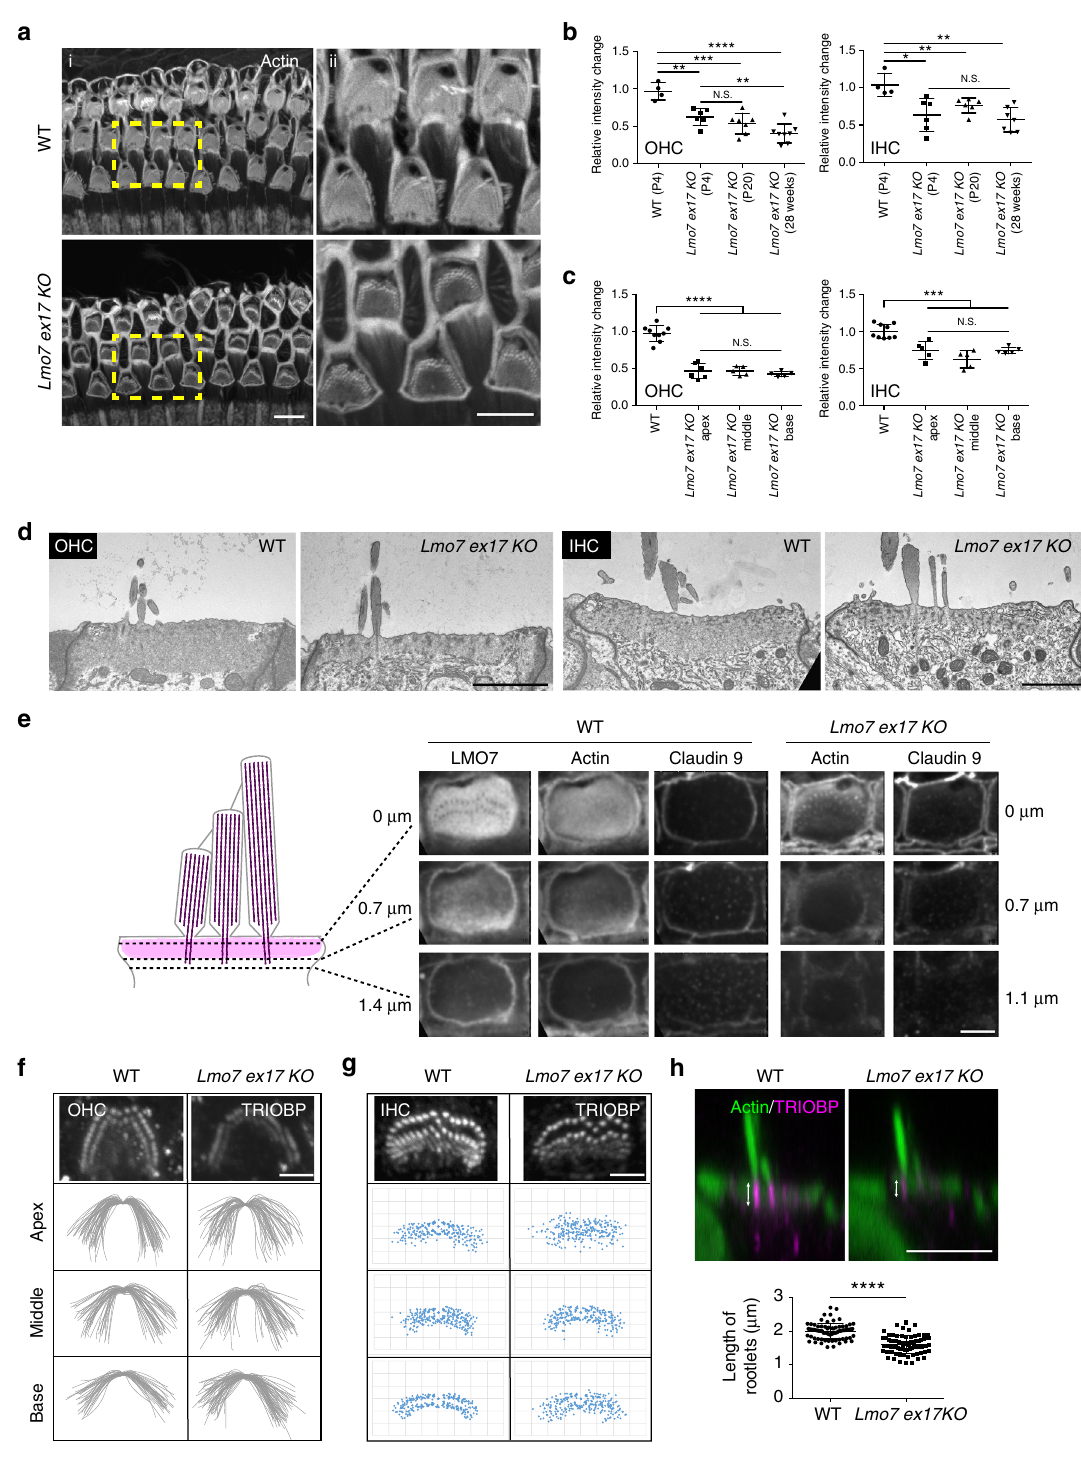
transfected with a construct coding for LMO7 tagged with GFP at the C-terminus. As illustrated in Fig. 5b, c ( fi rst columns), COS-7 cells transfected with WT LMO7-GFP exhibited a highly distinct densations of F-actin that were mostly co-localized with LMO7- fected COS-7 cells (Fig. 5b, c, fi rst columns). To characterize the we generated LMO7-GFP constructs in which the CH, LIM,